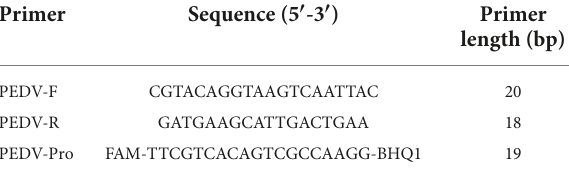
TABLE 1 Primers for porcine epidemic diarrhea virus (PEDV) detection. Primer Sequence (5 (cid:48) -3 (cid:48) ) Primer